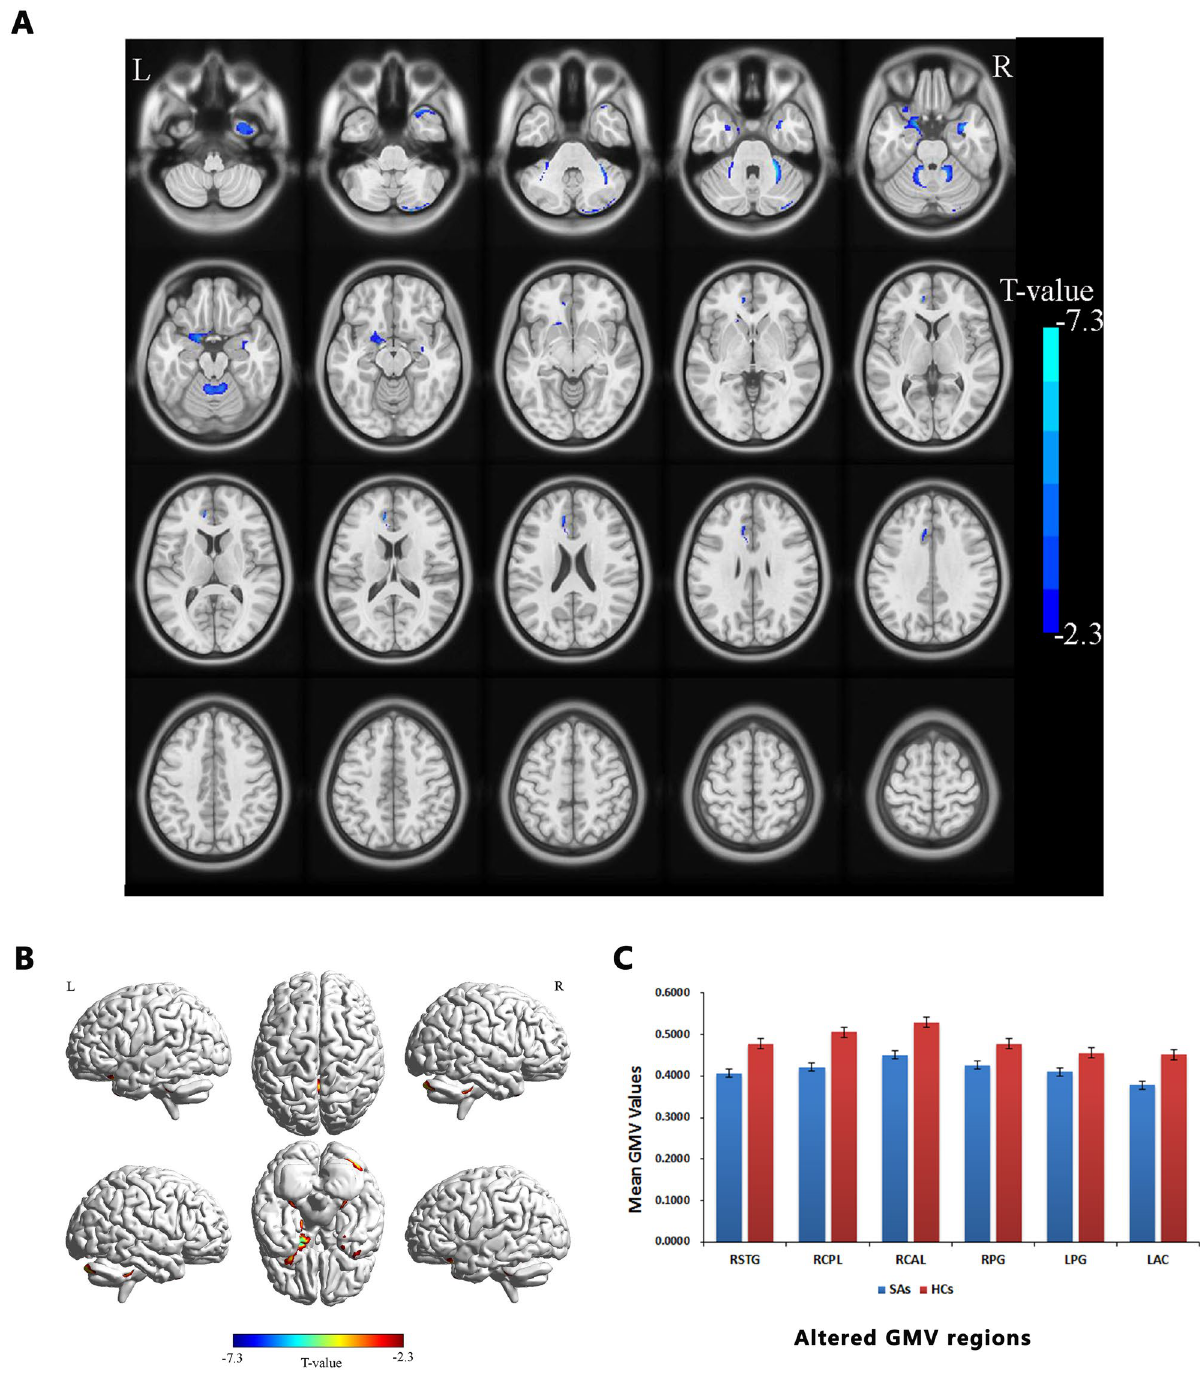
Figure 1. Voxel-wise comparison of GMV in the SA and HC group. Notes : ( A , B ) Significant differences in GMV were observed. The blue regions denote lower GMV values. ( C ) The mean GMV values between the SA and HC groups. GMV gray matter volume, SA strabismus with amblyopia, HC healthy control, RSTG right superior temporal gyrus, RCPL right posterior lobe of cerebellum, RCAL right anterior lobe of cerebellum, RPG right parahippocampal gyrus, LPG left parahippocampal gyrus, LAC left anterior increased degree centrality values of the right superior temporal gyrus 26 . Several investigations have focused on subjects with anisometropic amblyopia, who also showed increased spontaneous brain activity in the superior temporal gyrus 28,32 . Nevertheless, Huang et al. reported significantly reduced fractional anisotropy values in the superior temporal gyrus of subjects with concomitant strabismus 27 . Moreover, patients with primary open-angle glaucoma displayed reduced GM density, mainly in the left superior temporal gyrus 12 . In the present study, the